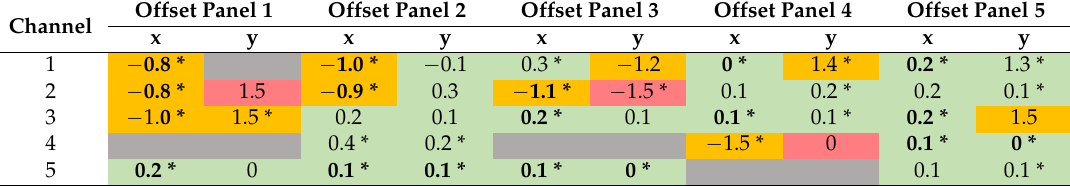
Figure 7. Separated inertia sensor-FlexPac.